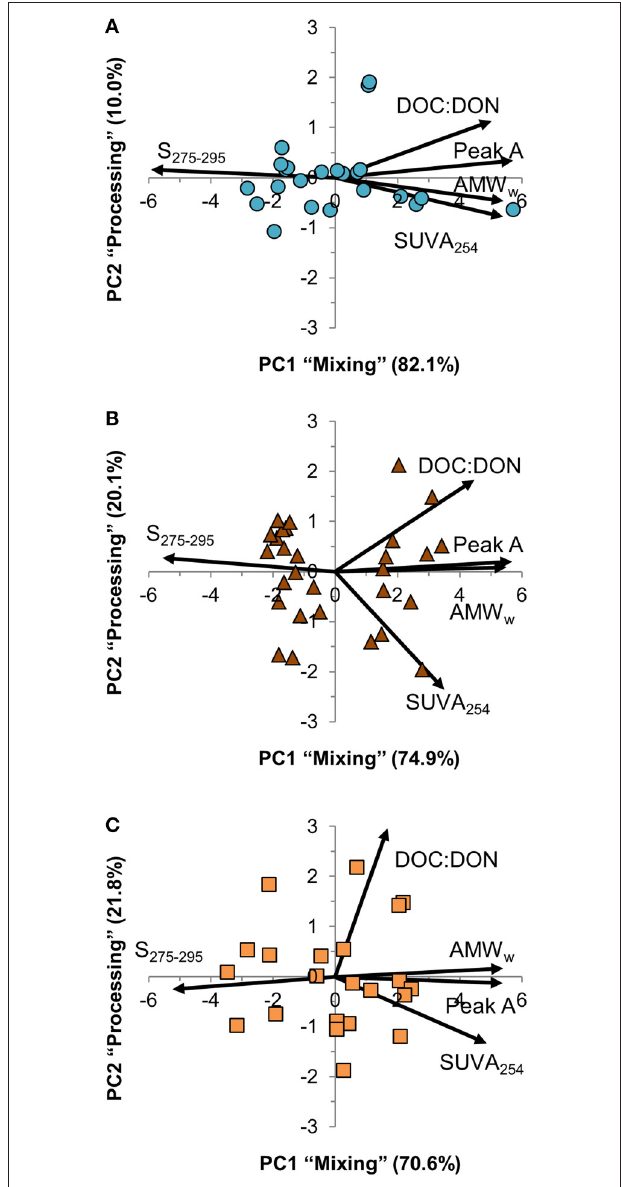
FIGURE 5 | Principal component analysis (PCA) correlation biplot of the two first principal components (PC1 and PC2). Samples are shown as symbols and the contribution of the DOM quality variables to the principal components as vectors. The proportion of variation explained by both principal components is included with the axes titles. (A) Karjaanjoki, (B) Kiiminkijoki, and (C) Kyrönjoki